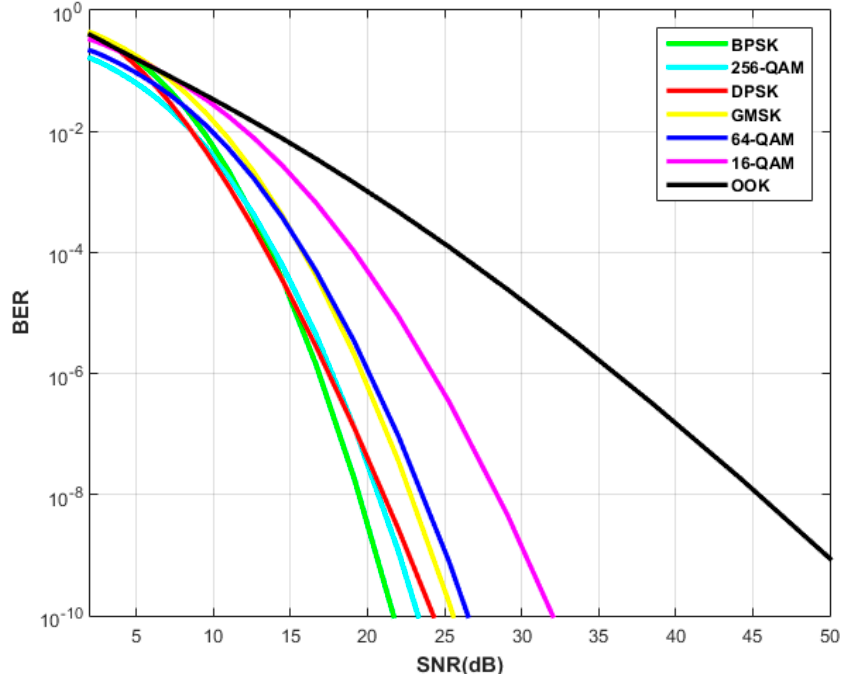
Figure 5. BER performance of different modulation formats without SDRT in a moderate turbulence channel.